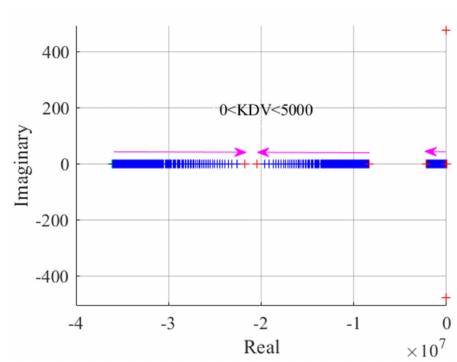
Figure 10. The DTL VSI eigenvalues.